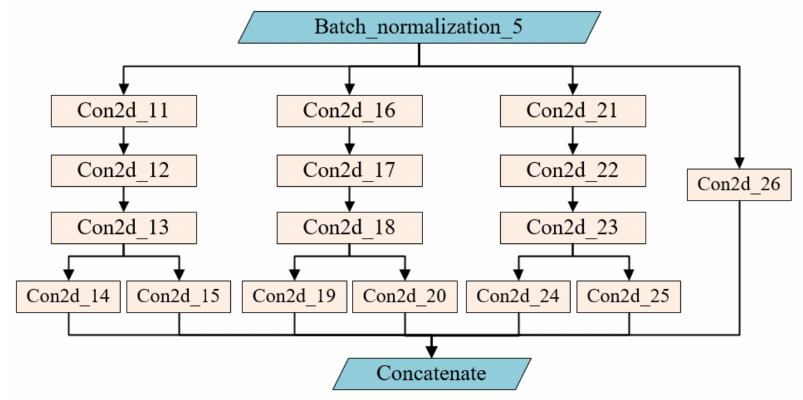
Figure 5. Multiscale Convolution Group